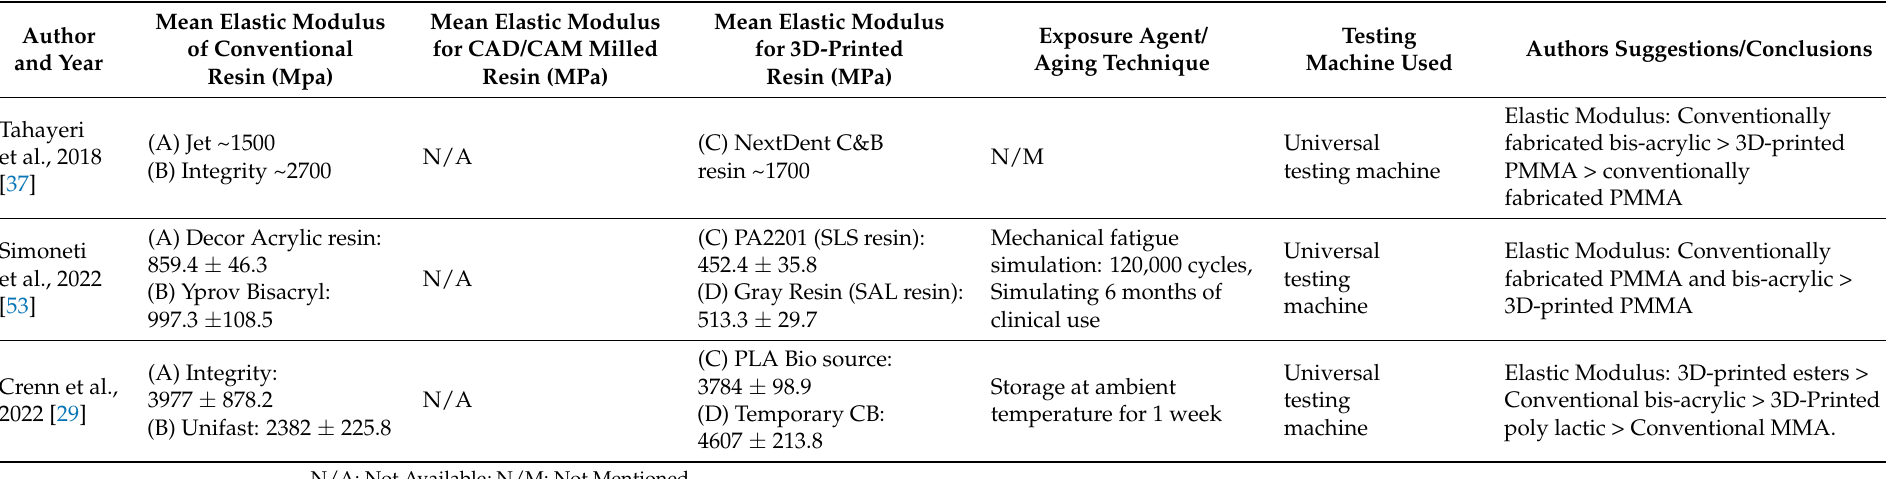
Table 12. Elastic Modulus Results.